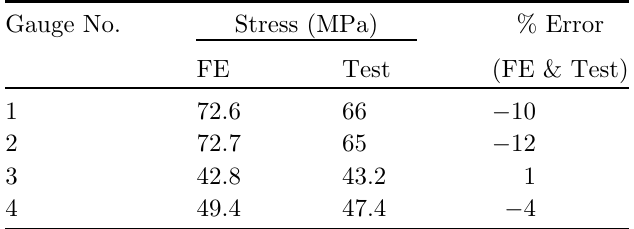
Table 3. Comparison of FE and test results at load of 9800